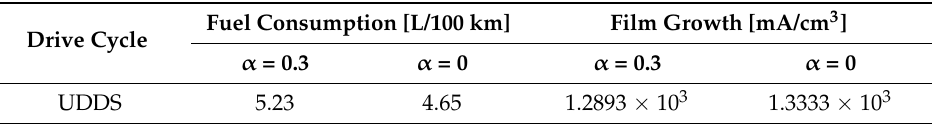
Table 3. Fuel consumption and film growth over a single UDDS cycle.